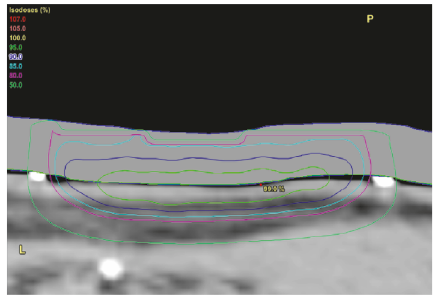
Figure7:Electronsdobestwhenaflatsurfaceistreatedwithabeam perpendicular to the surface. Here in this image the 90% isodose line, which is the line that is the dose prescription line, straddles the skin surface, a good plan. The wires are marking the field. The dose drop-off towards the subcutis is